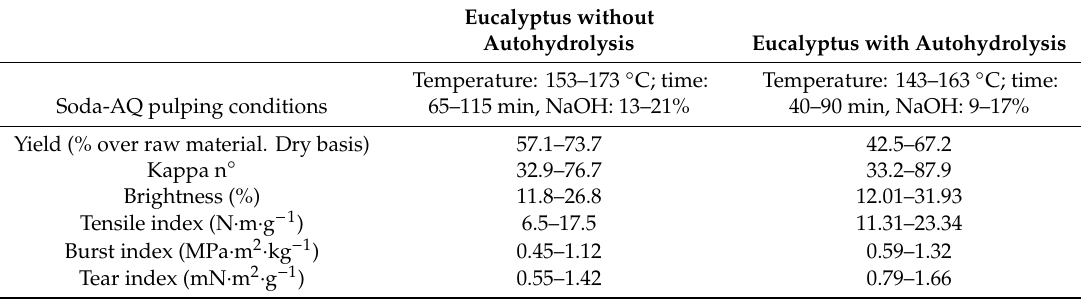
Table 5. Results of soda-AQ pulping with Eucalyptus with and without previous autohydrolysis. Eucalyptus without